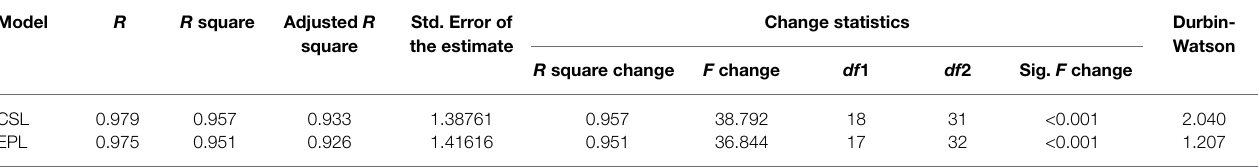
TABLE 5 | Model summary of actual playing time of CSL and EPL. Model R R square Adjusted R